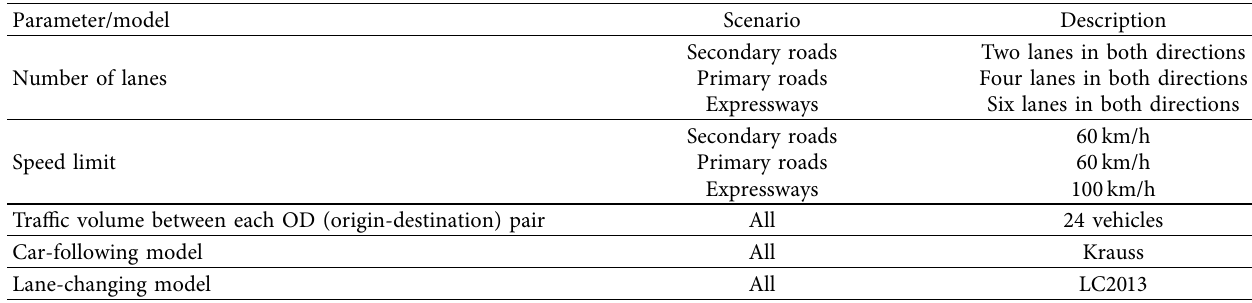
Table 1: Parameters and model settings of simulation